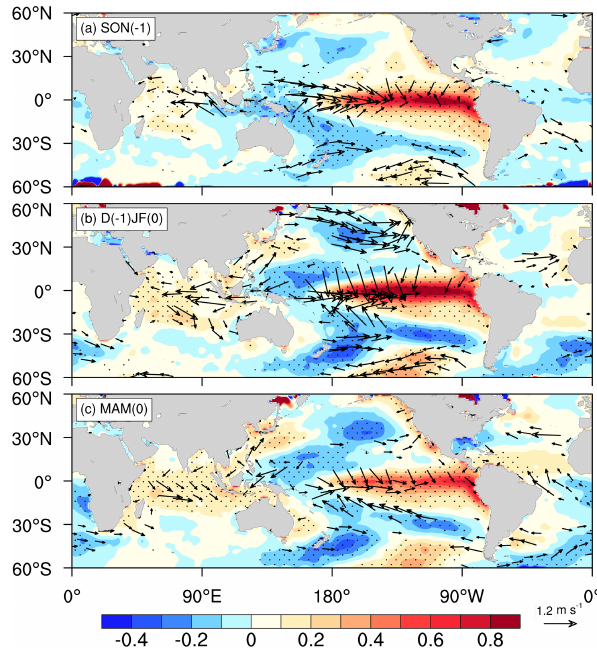
Figure 3. Regressions of sea surface temperature (SST) anomalies (shading; ◦ C) and 10m surface wind anomalies (vector; ms − 1 ) onto the standardized AODI_IA in the (a) preceding autumn (SON( − 1)), (b) preceding winter (D( − 1)JF(0)), and (c) simultane- ous spring (MAM(0)). Stippling and vectors denoting the regressed SST and wind are statistically significant at the 95% confidence level based on the Student’s t test,